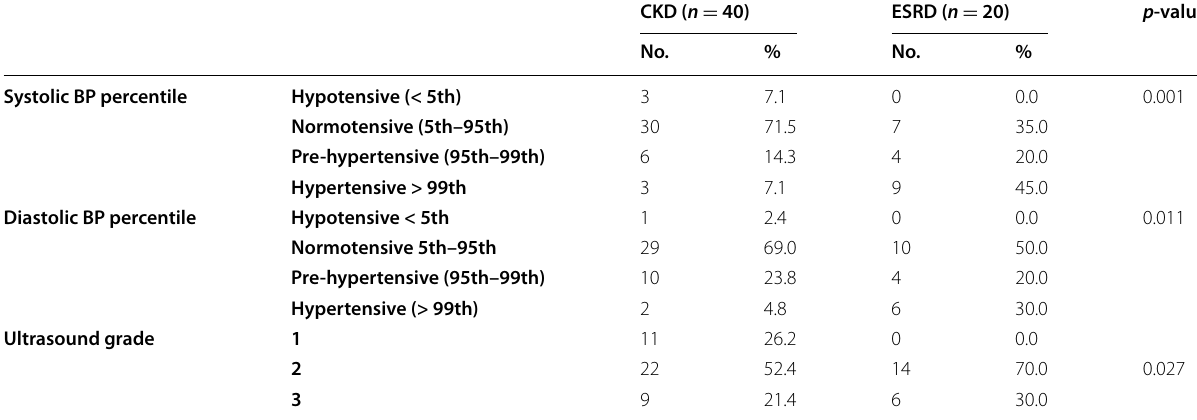
CKD chronic kidney disease, ESRD end-stage renal disease